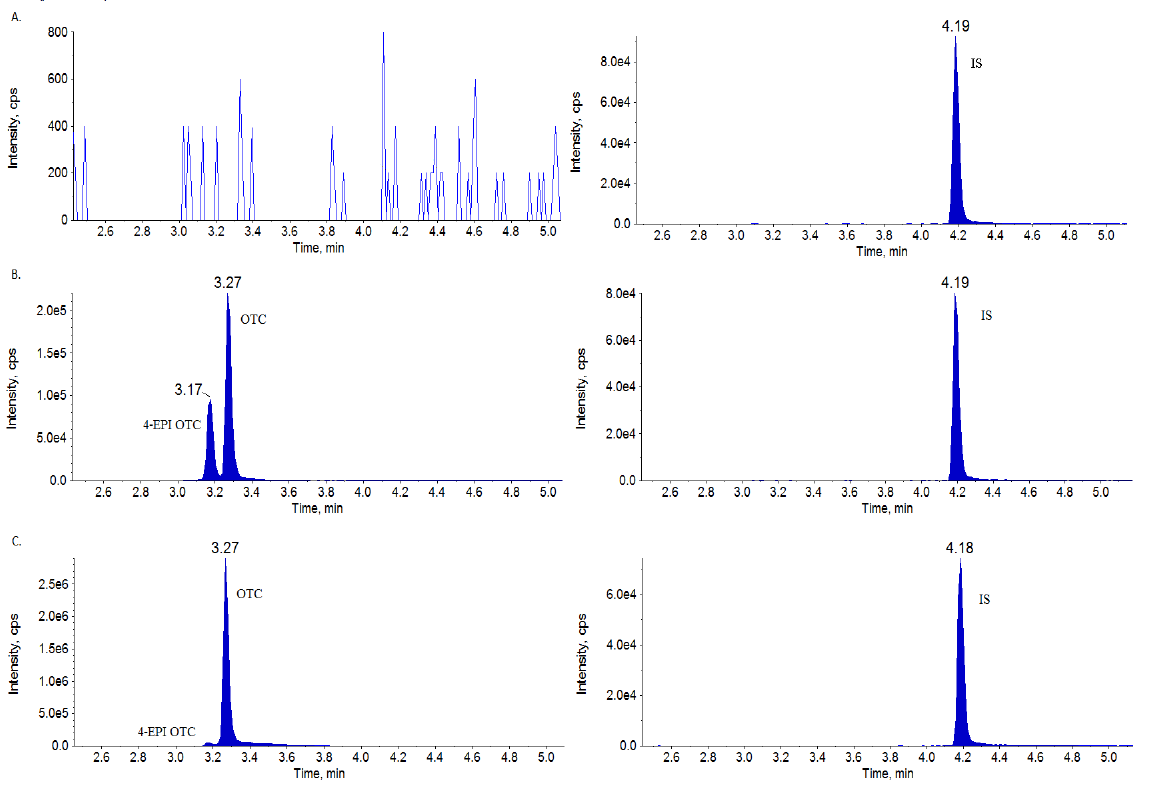
Figure 2. Ion chromatograms (transition for OTC and 4-epi-OTC: 461 → 426 and IS: 465 → 448) of ( A ) blank milk sample; ( B ) OTC and 4-epi-OTC milk sample fortified at 100 µ gL − 1 ; ( C ) milk sample obtained 1 day after the intramuscular injection of veterinary medicinal product with OTC at a concentration of 1120 µ gL − 1